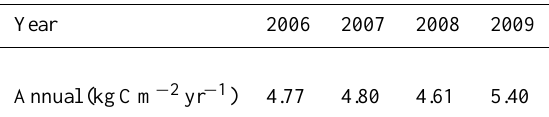
Table 1. Total annual carbon dioxide flux in the northwest part of Beijing from 2006 to 2009. The annual values were estimated from the gap-filled dataset.